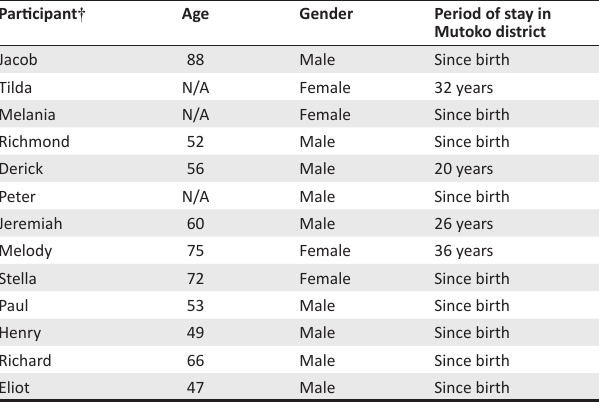
TABLE 1: In-depth interview